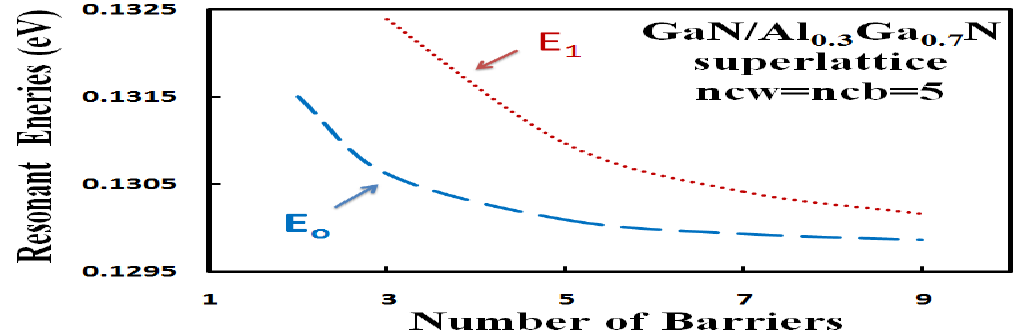
Fig. 4: Relationship between the ground state level E